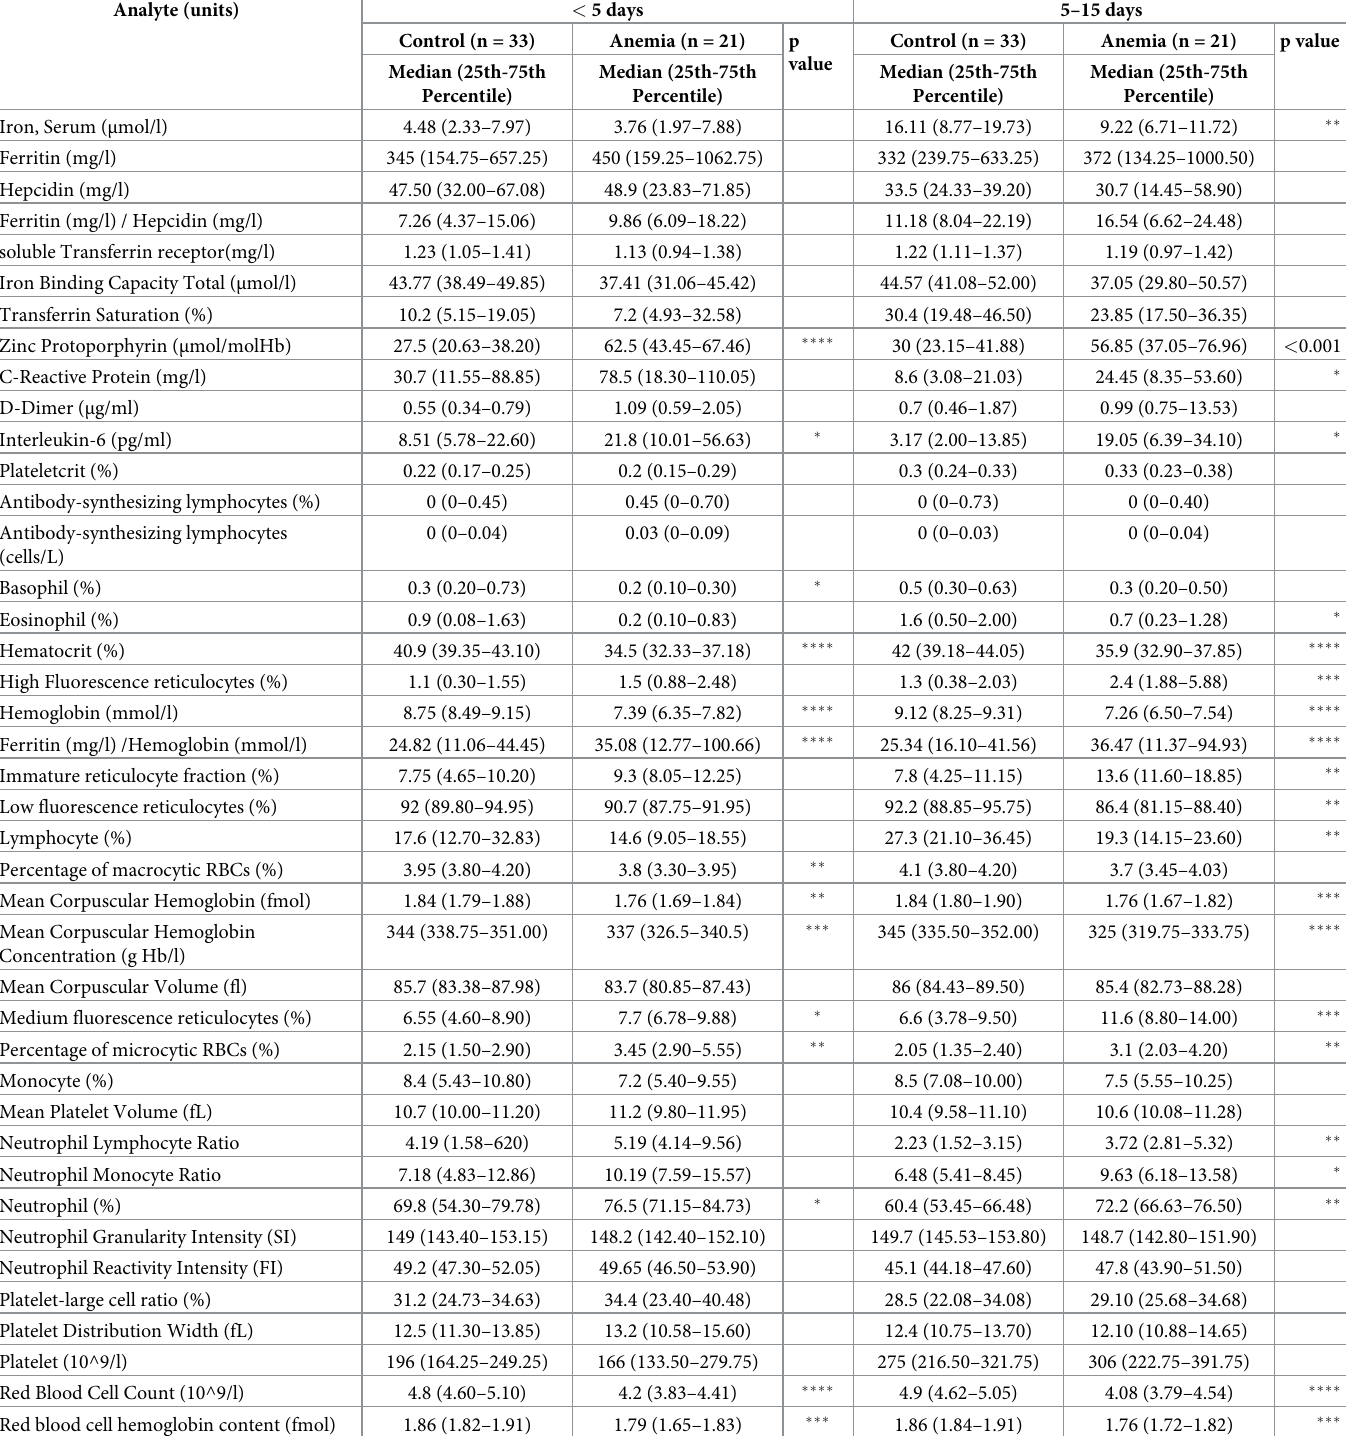
Table 2. Statistical differences between control and anemia subjects in two different time points ( < 5 days and 5–15 days) based on CBC and other hematological parameters. Analyte